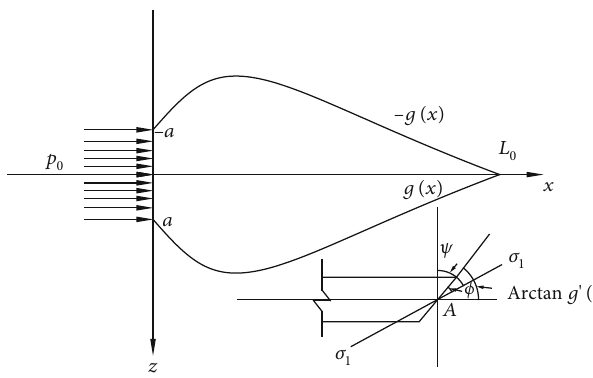
Figure 3: Calculation model of failure envelopes of soil underlying the anchor beam by horizontal line load.